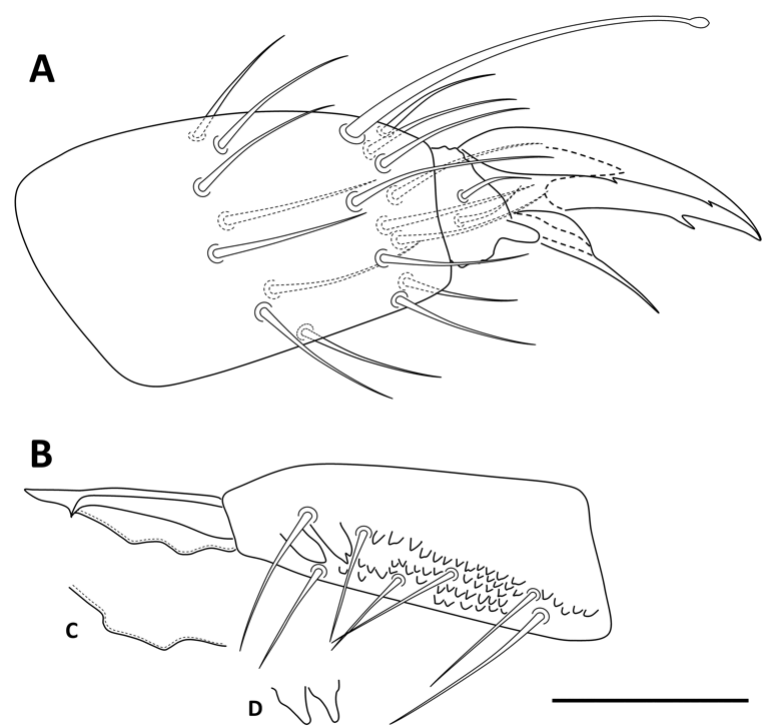
Figure 7. Ceratophysella meridionalis : ( A ) tibiotarsi; ( B ) dentes and mucro, with detail of the variations in the lamellae of mucro shape ( C ) and tubercle shaped teeth ( D ) (scale bar, 0.05 mm). Anal spines 0.8 times shorter than inner edge of claw, slightly curved, situated on long papillae the same length as the colorless spine (Figure 6).